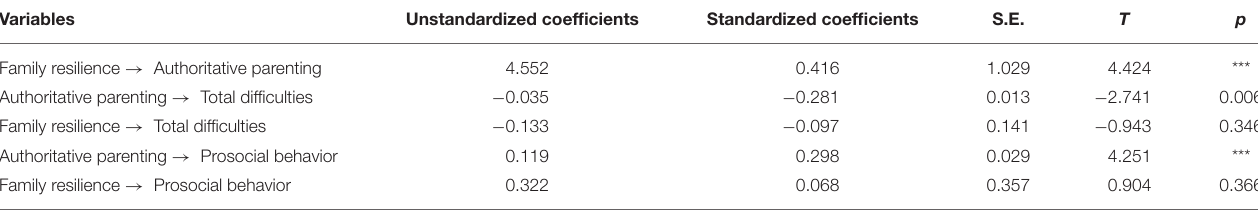
TABLE 4 | The model path diagram for family resilience, authoritative parenting and psychosocial adjustment of children with chronic illness. Variables